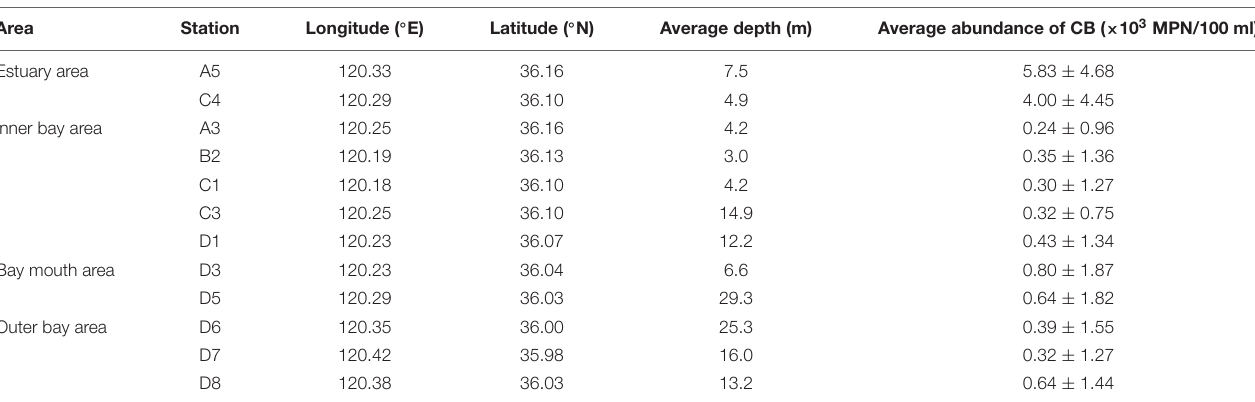
TABLE 1 | Average depths with the CB abundance of the sampling